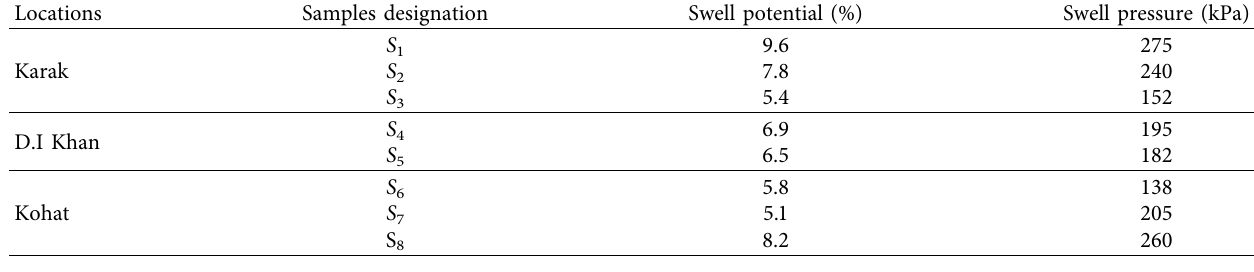
p ) of the investigated expansive soils.